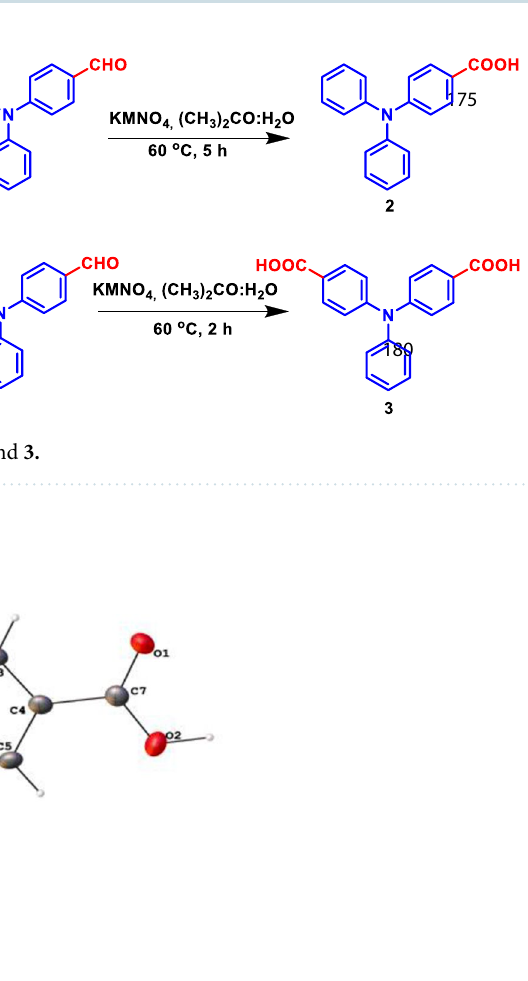
Figure 1. The thermal ellipsoidal plot of compound 2 (TPA monoacid). The unit cell dimensions are a = 9.1921(6) Åα= 90°.b = 9.6185(7)Å β = 90.068(2)°.c = 17.1694(11) Å γ = 90°. The crystal system is monoclinic with a volume of 1518.02(18) Å 3